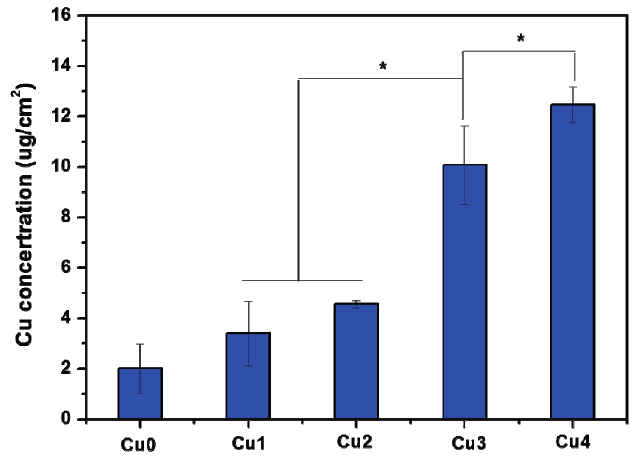
Figure 4. The quantity results of Cu in the Cu0, Cu1, Cu2, Cu3 and Cu4 samples by micro BCA assay (mean ± SD, * p < 0.05, n = 3).